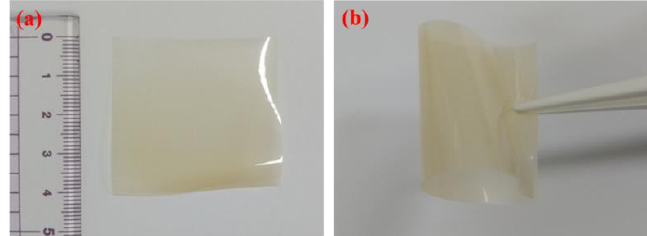
Figure 1. Digital photographs XYX membrane ( a ) flat view and ( b ) folded view.